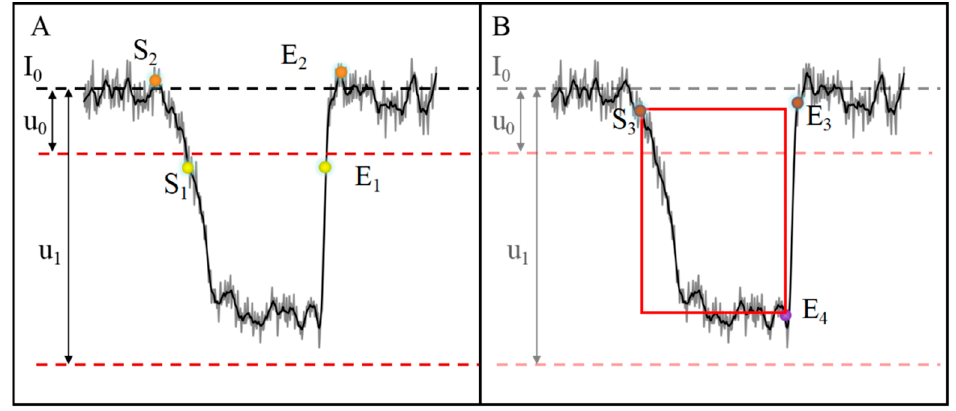
Figure 3. ( A ) The detection and ( B ) the correction of molecular events. S means the start point, and E means the end point.